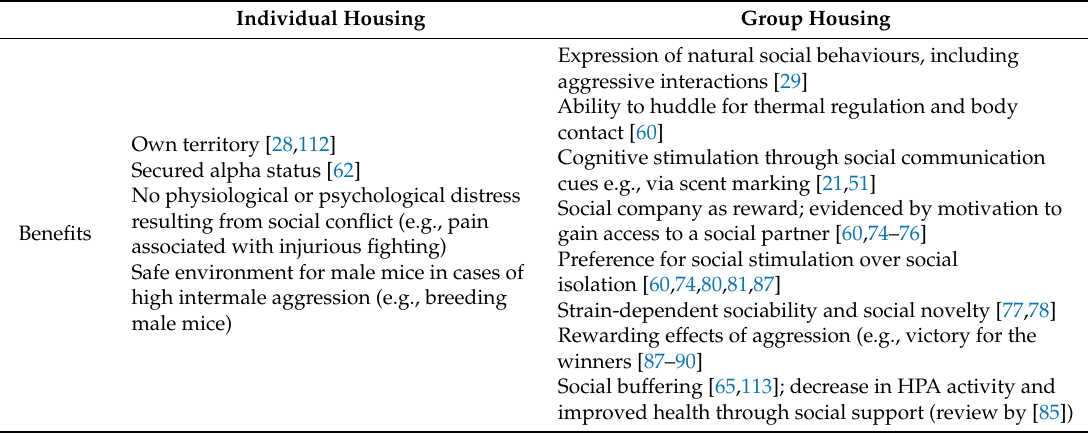
Table 3. Benefits and harms of individual and group housing for male laboratory